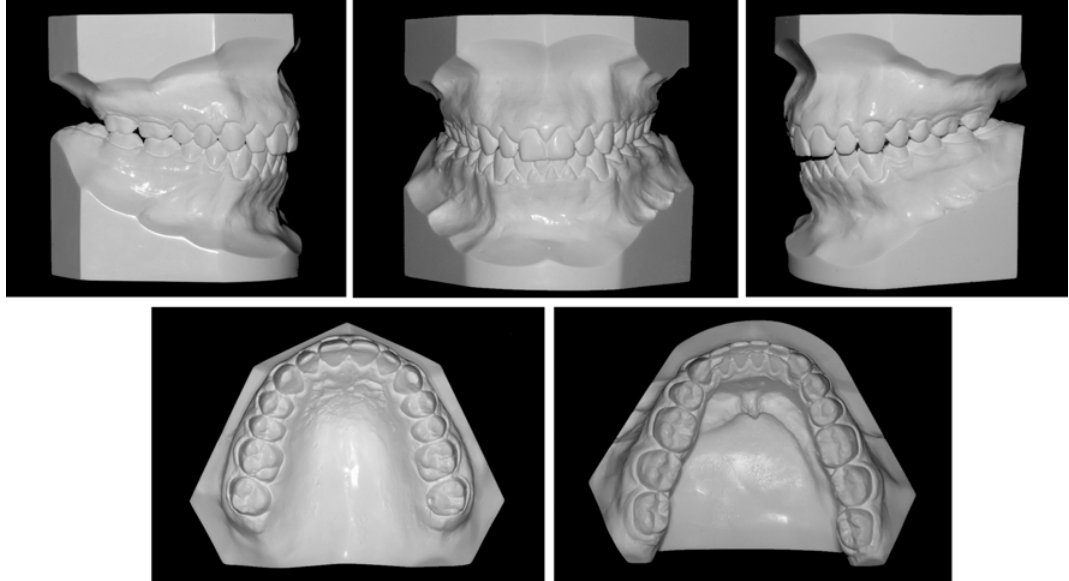
FIGURE 6- Posttreatment study